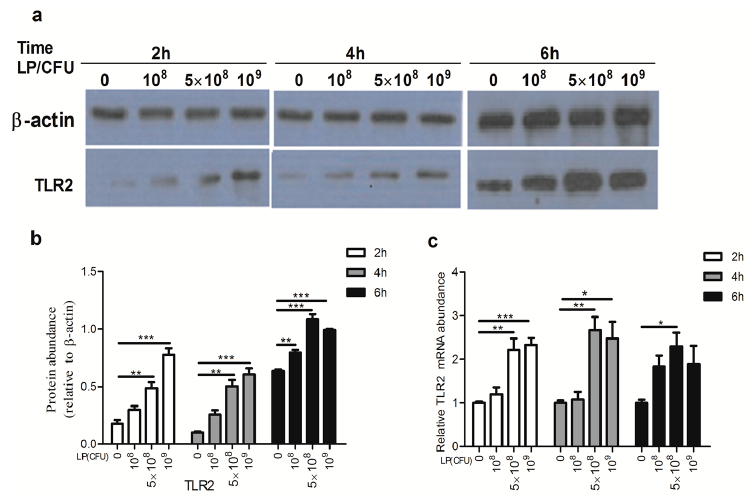
Figure 3. Lactobacillus plantarum (LP) increased the expression of TLR2. NK cells were untreated or treated with L. plantarum (10 8 , 5 × 10 8 or 10 9 CFU/mL) for 2, 4, or 6 h. Cells were collected and the level of TLR2 mRNA and protein was analyzed. ( a ) Western blots of the amounts of TLR2 protein. Loading and transfer of equal amounts of protein was confirmed by the immunodetection of β -actin; ( b ) The ratios of TLR2 to β -actin. Similar results were obtained from 3 independent experiments; ( c ) Relative expression of TLR2 mRNA. TLR2, Toll-like receptor 2. Data are means ± SEM. * p < 0.05, ** p < 0.01, *** p < 0.001.